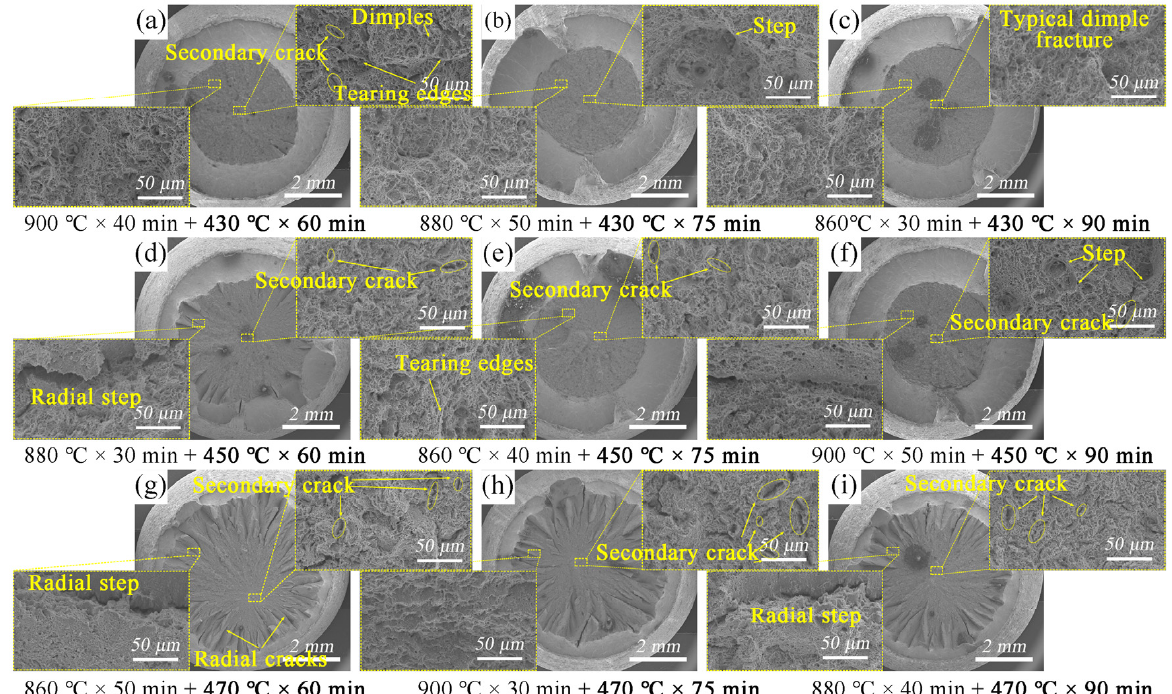
Figure 7. The fracture surface of tensile specimens corresponding to different tempering conditions: ( a ) No.7; ( b ) No.4; ( c ) No.1; ( d ) No.5; ( e ) No.2; ( f ) No.8; ( g ) No.3; ( h ) No.9; ( i ) No.6.